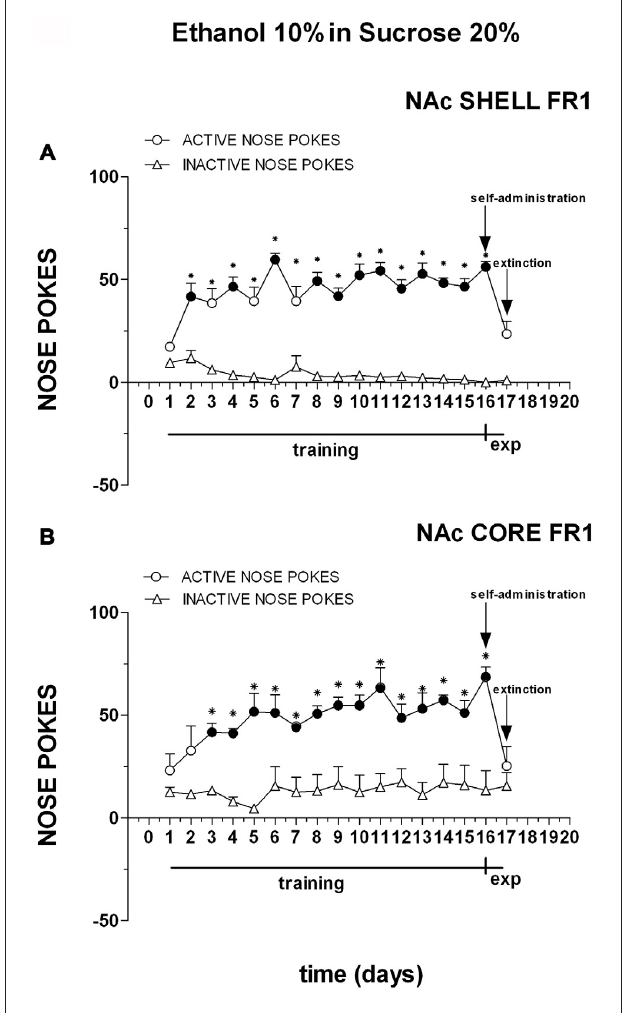
FIGURE 5 | Cumulative active (circles) and inactive (triangles) nose-pokes during training for FR1 responding for 10% ethanol in 20% sucrose solution and during dialysis experiments. Data are means ± SEM of the results obtained in rats implanted with guide cannulas in the NAc shell (A) ( N = 6) and rats in the NAc core (B) ( N = 6). Filled symbols, p < 0.05 vs. 1st day; ∗ p < 0.05 vs. inactive nose